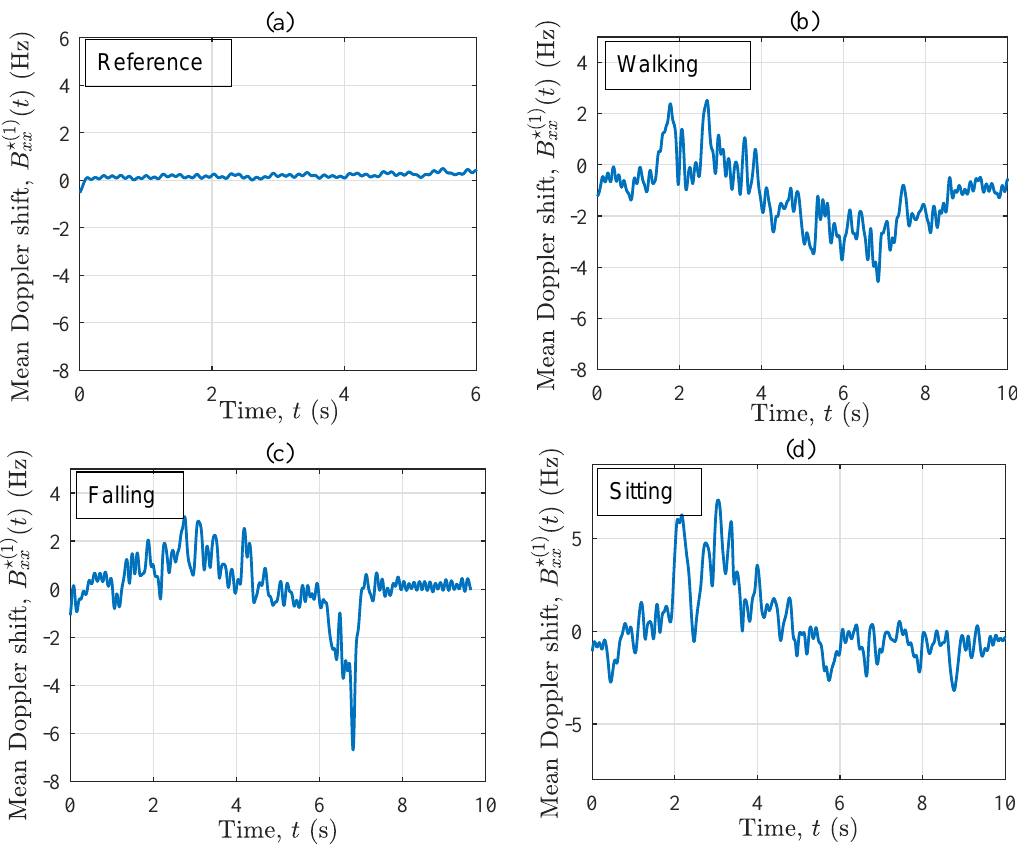
(cid:63) ( 1 ) ( t ) for the four scenarios in S1: ( a ) reference, xx